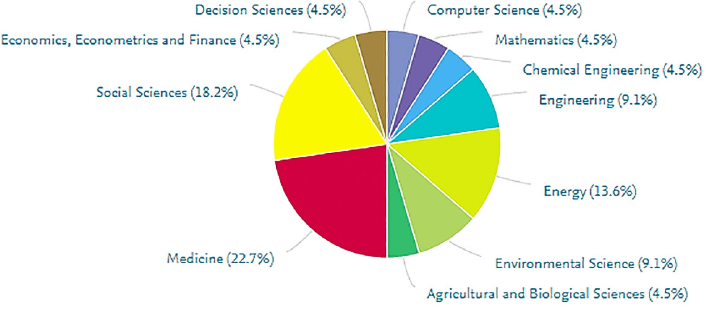
Figure A3. Structural analysis by subjects for the case of SDG 7 and Responsible Investment